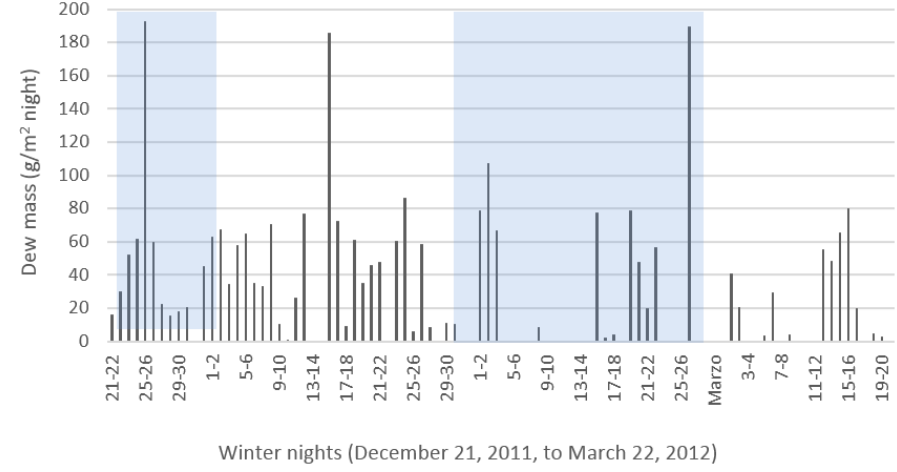
Figure 7. Dew condensation throughout the winter.